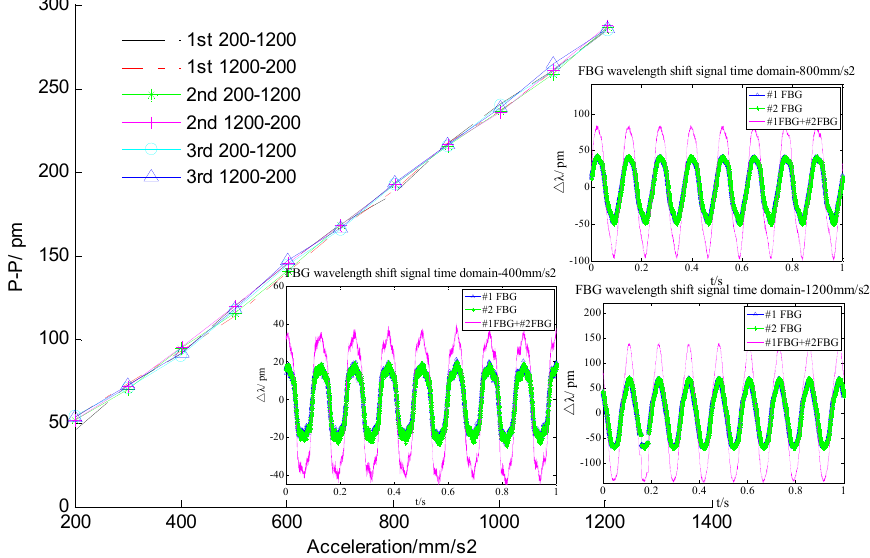
Figure 6. The addition value Δλ 2 + Δλ 1 versus applied acceleration a y —the inset shows the center wavelength shift response in the time domain with a y of 400 mm/s 2 , 800 mm/s 2 and 1200 mm/s 2 .